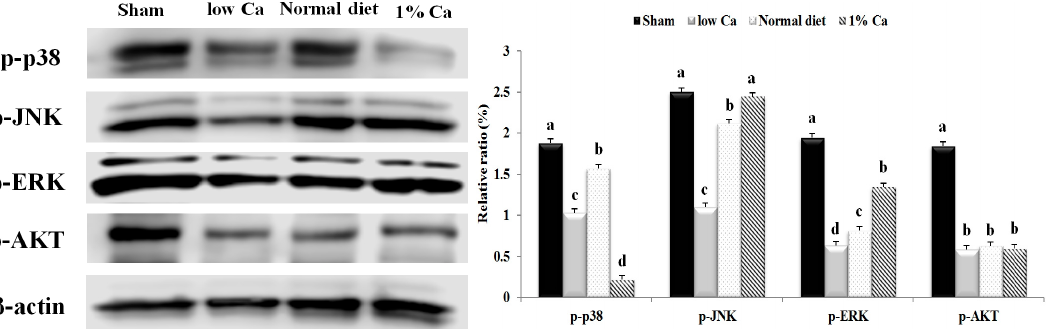
Figure 7. The expression level of phosphorylated p38, c-Jun N-terminal kinase (JNK), extracellular signal-regulated kinase (ERK) and serine/threonine kinase (AKT) in sham, low Ca, normal diet and 1% Ca groups. Results are expressed as the means ± standard deviation (SD). Values not sharing a common superscript ( a , b , c and d ) differed significantly (Duncan’s multiple range test).